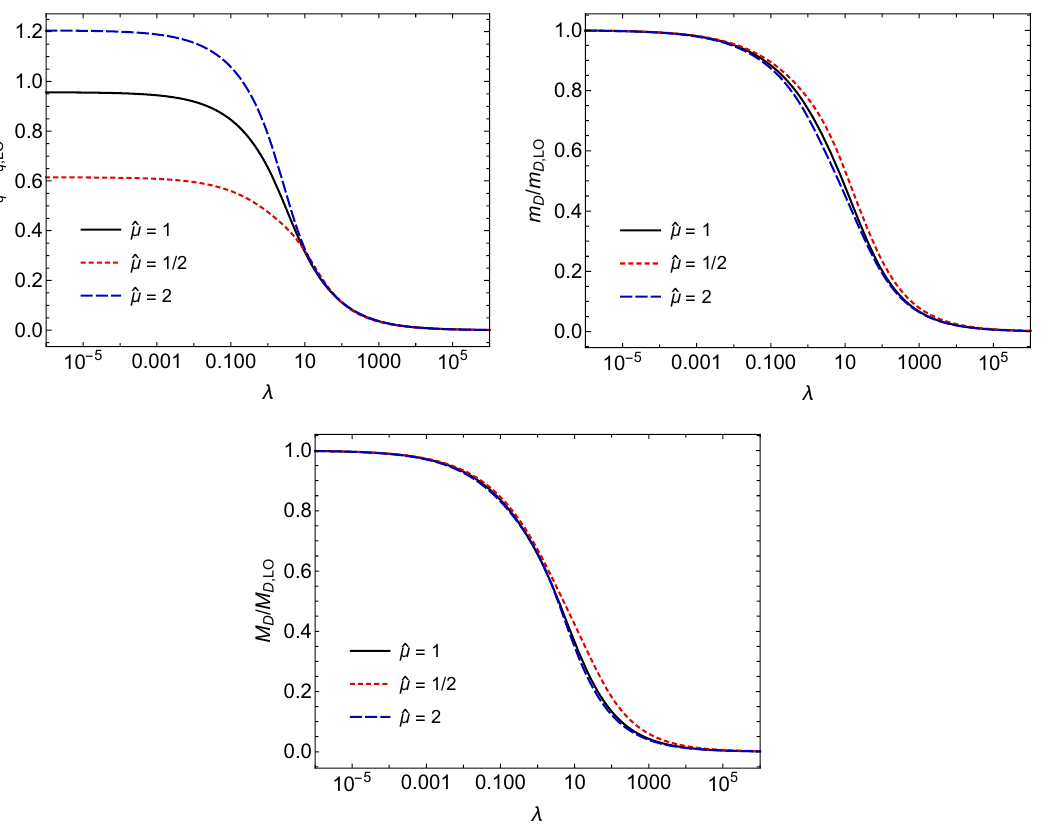
Figure 4 . Numerical solution of gap equations for m q , m D , and M D as a function of (cid:21) . In each panel the results are scaled by their corresponding leading-order weak-coupling